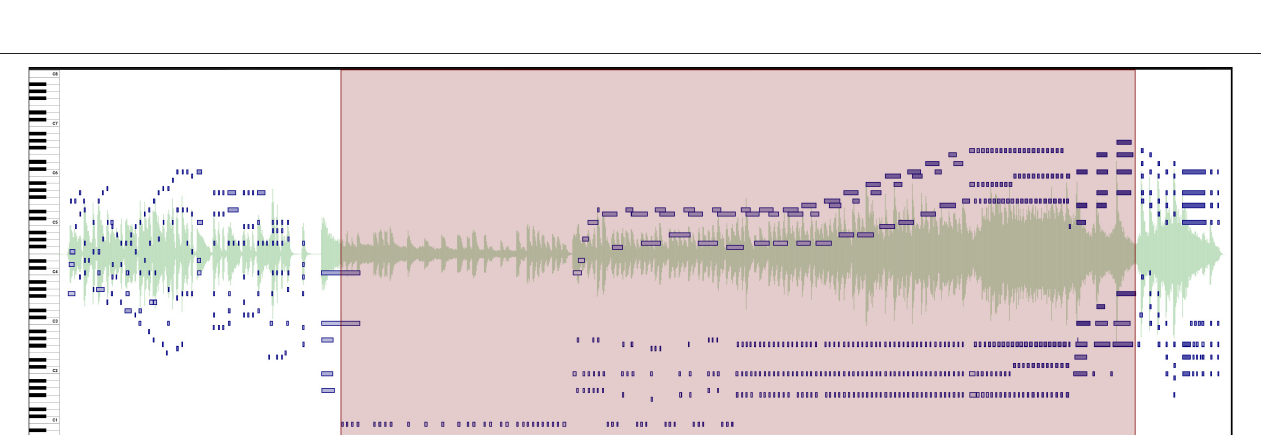
FIGURE 4 | Excerpt of Beethoven’s Symphony No. 5 in C minor, Mvt II. Boundaries (red vertical lines) in this example are assigned according to the strength of the change. Stronger boundaries have a thicker, less opaque red color. See Supplementary Video 2 in the Supplementary Materials to hear the music presented in this Figure.